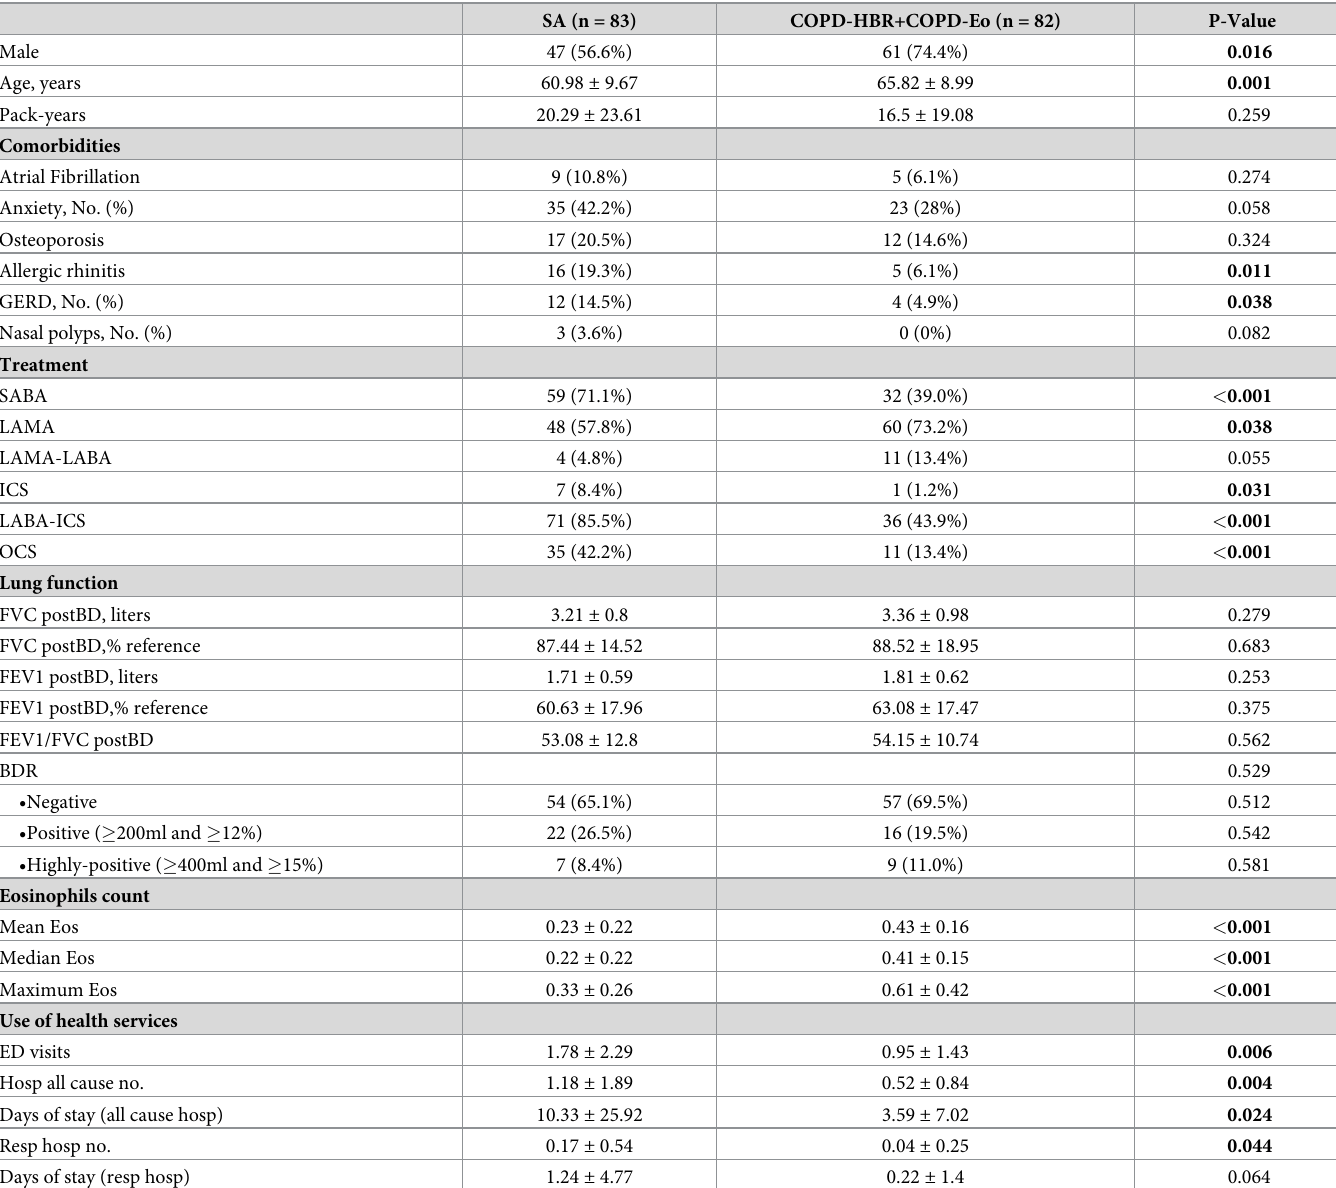
Table 3. Demographic and clinical characteristics of smoker asthmatic (SA) and COPD with asthma features (COPD-HBR+COPD-Eo) populations. SA (n =